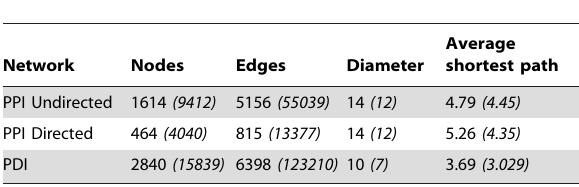
Table 3. Results of general network